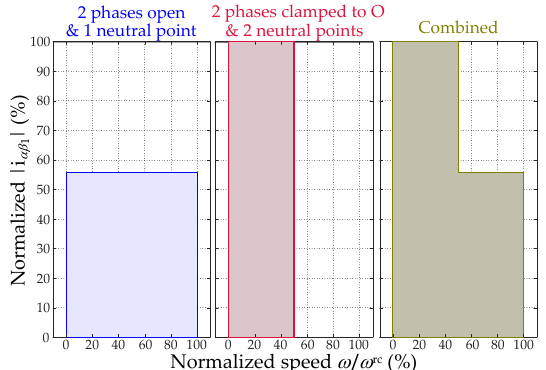
Figure 13. Reconfiguration strategy proposed in [24] based on alternating between phases open or clamped to O, considering the particular case with IGBT OC faults in phases a and d, and with bidirectional switch between neutral points [24]. ( a ) Speed under half its rating ( ω < ω rc /2). ( b ) Speed over half its rating ( ω > ω rc /2).